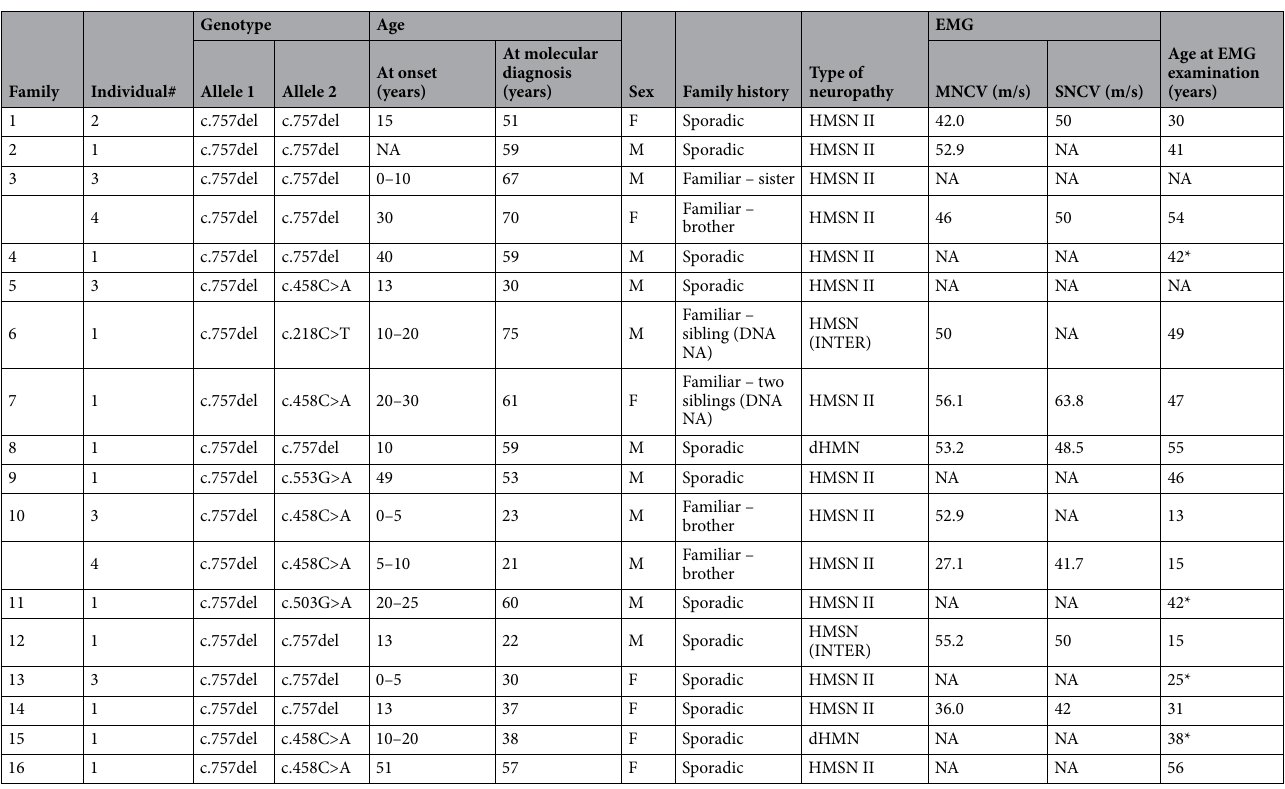
Table 2. The characterization of patients with SORD neuropathy. # Individual, this number corresponds with the number in the Fig. 4 (Pedigrees); where no additional family members were available # = 1; F female; M male; NA not available; HMSN II axonal type of neuropathy; INTER Intermediate type of HN; dHMN distal hereditary motor neuropathy; EMG electromyography; Nerve conduction velocities for n. medianus: MNCV motor nerve conduction velocity; SNCV sensory nerve conduction velocity. *EMG exam was done, but results are available only in the form of a commentary (not numerical